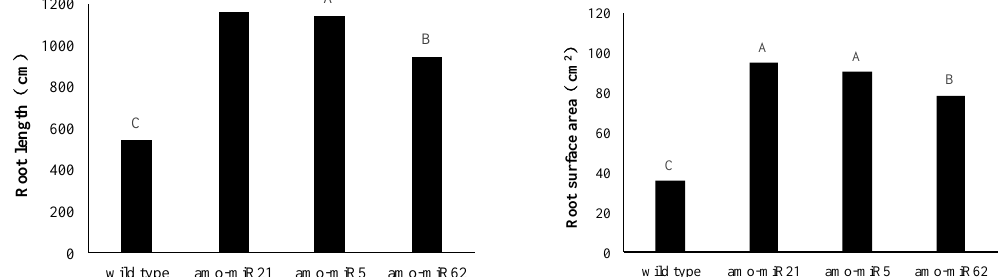
Figure 11. Root characteristics of transgenic Arabidopsis lines at 18 h under 15% PEG treatment. Note: Different letters on the column indicate significant difference at 0.01 level.